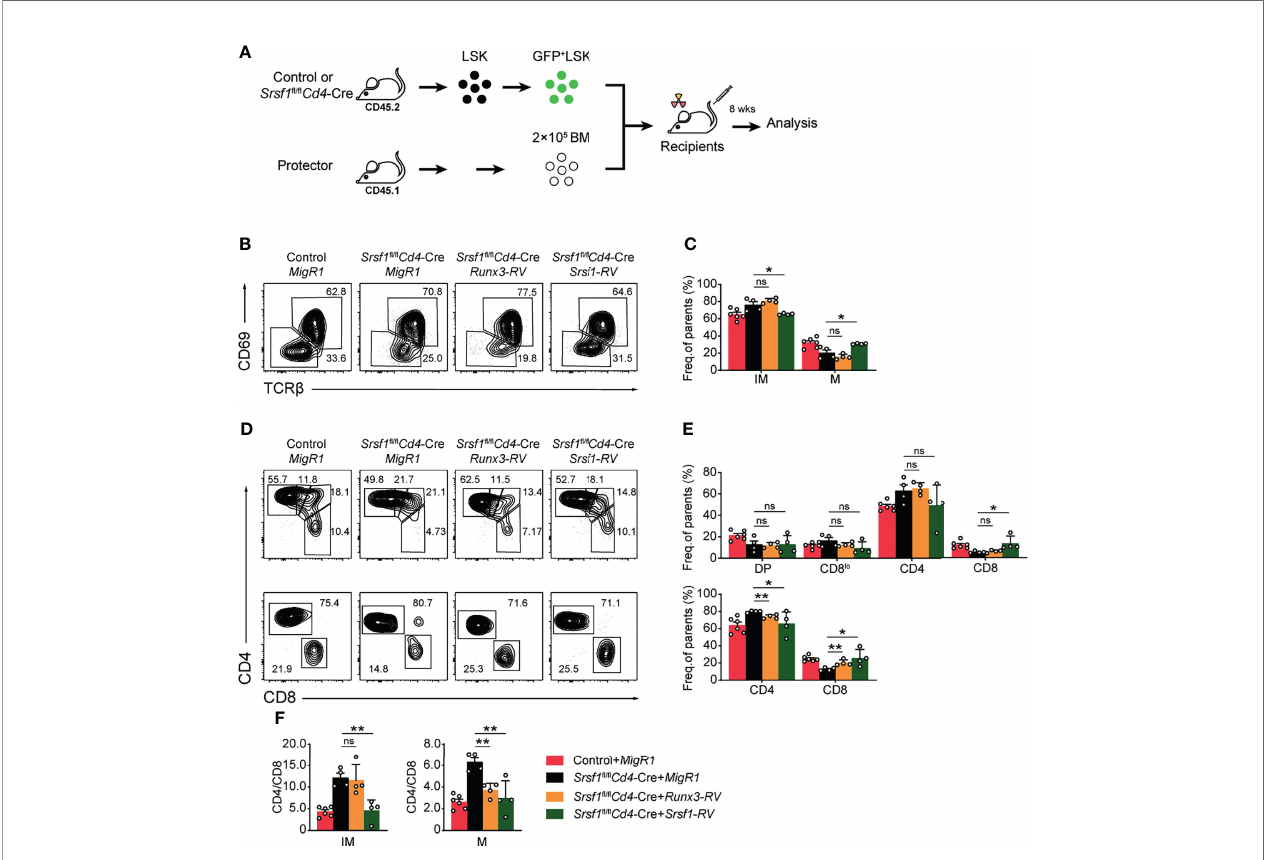
FIGURE 6 | Overexpression of Runx3 partially rescues the defects of CD8 + T proportion in Srsf1 fl / fl Cd4 -Cre mice. (A) The fl ow chart shows the experimental design of bone marrow chimeric mice by using Runx3 - or Srsf1 -contained retroviral transduction. (B) Analysis the post-selection thymocytes from chimeric mice. TCR b hi thymocytes were further fractionated into CD69 + CD24 + immature and CD69 − CD24 − mature subsets. (C) The frequency of indicated subsets in (B) was shown, accordingly (n ≥ 4). (D) The immature subsets were subdivided into CD4 + , CD4 + CD8 lo , DP, and CD8 + sub-populations (clockwise from top left in the top row), and the mature subsets were further subdivided into CD4 + and CD8 + populations (bottom row). (E) The frequency of indicated subsets in (D) was shown, respectively. (F) The ratio of CD4 + to CD8 + cells from immature and mature subsets of TCR b hi thymocytes was calculated and shown, accordingly (n ≥ 4). Data were collected from at least two independent experiments. The error bars are means ± SD. Statistical signi fi cance was determined by one-tailed Student ’ s t -test. ns, not statistically signi fi cant; * P < 0.05 and ** P <